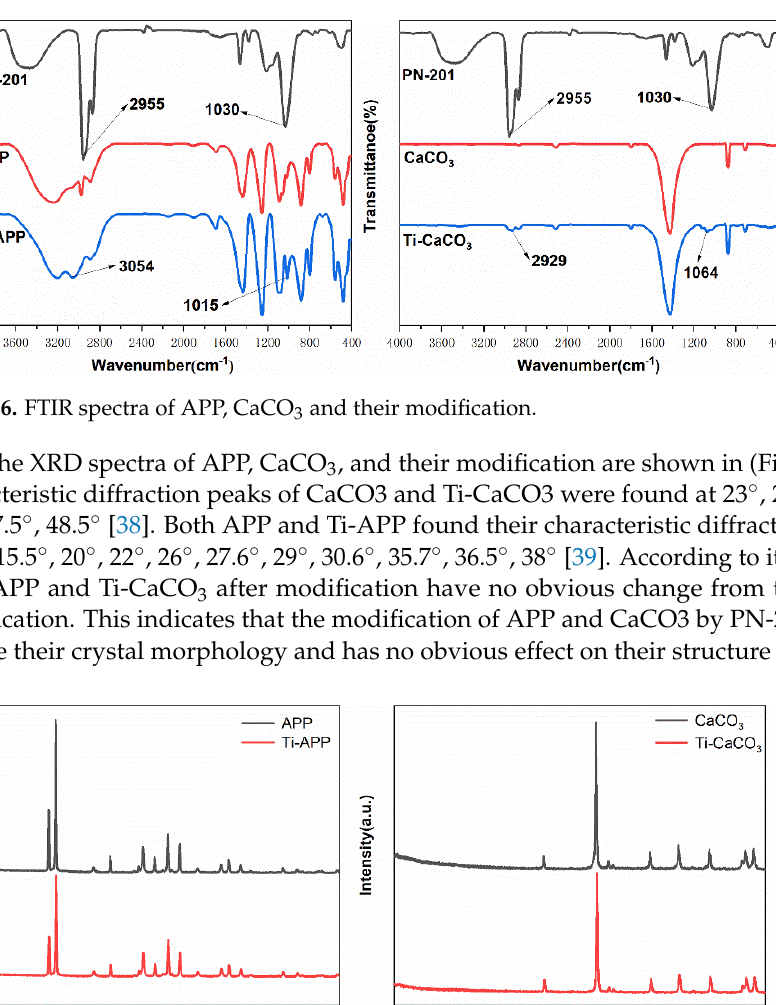
Figure 7. XRD spectra of APP, CaCO 3 and their modification.